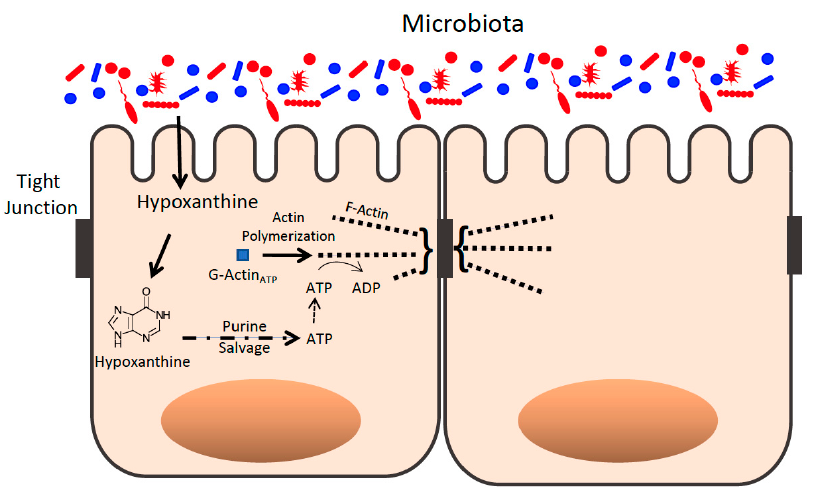
Figure 4. Purines derived from microbial sources influence the epithelial apical tight junction actin complex. Purines such as hypoxanthine are derived, in part, from microbial sources and are salvaged as templates for ATP generation that supports actin polymerization of G-actin to F-actin in the apical epithelial TJ complex.